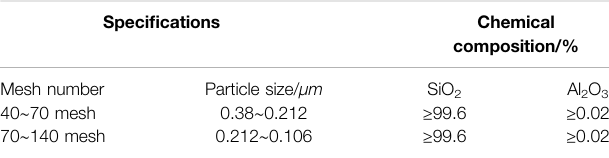
TABLE 2 | Physical indexes and chemical composition of quartz